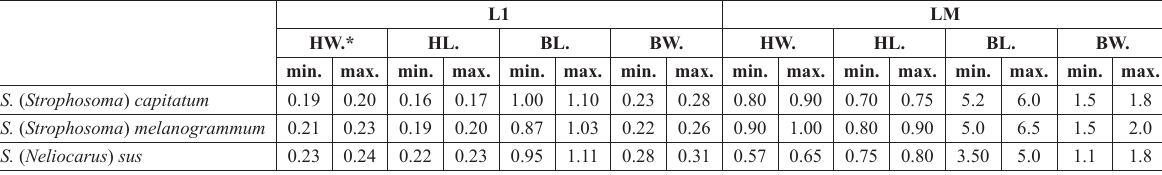
Table 1. Measurements of characteristic body parts of the Strophosoma species studied. HW – head width; HW* head width with prominent eyes included; HL - head length; BL – body length; BH – body height; L1 – first instar larvae, LM – larvae of last instars. All measurements in millimeters